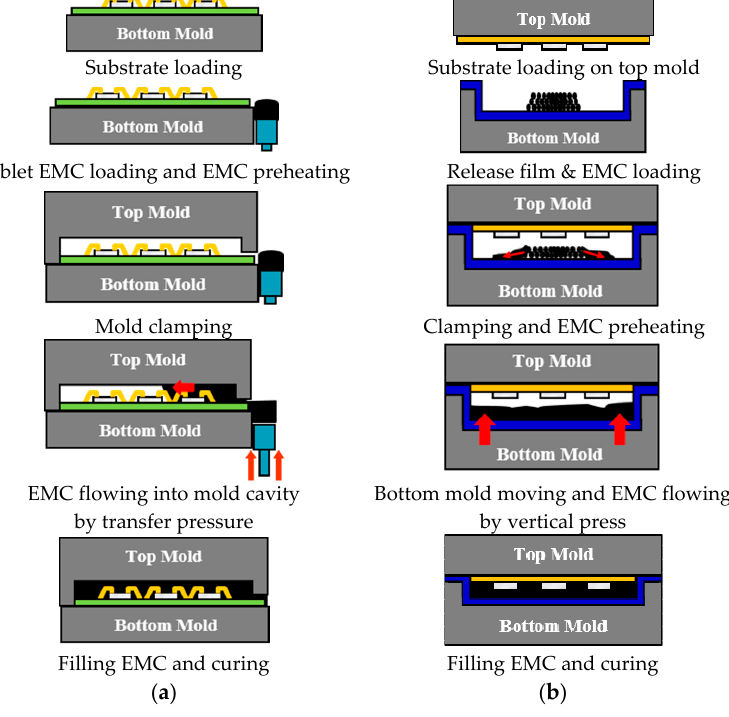
Figure 2. Comparison between semiconductor packaging molding processes: ( a ) transfer molding; ( b ) compression molding.